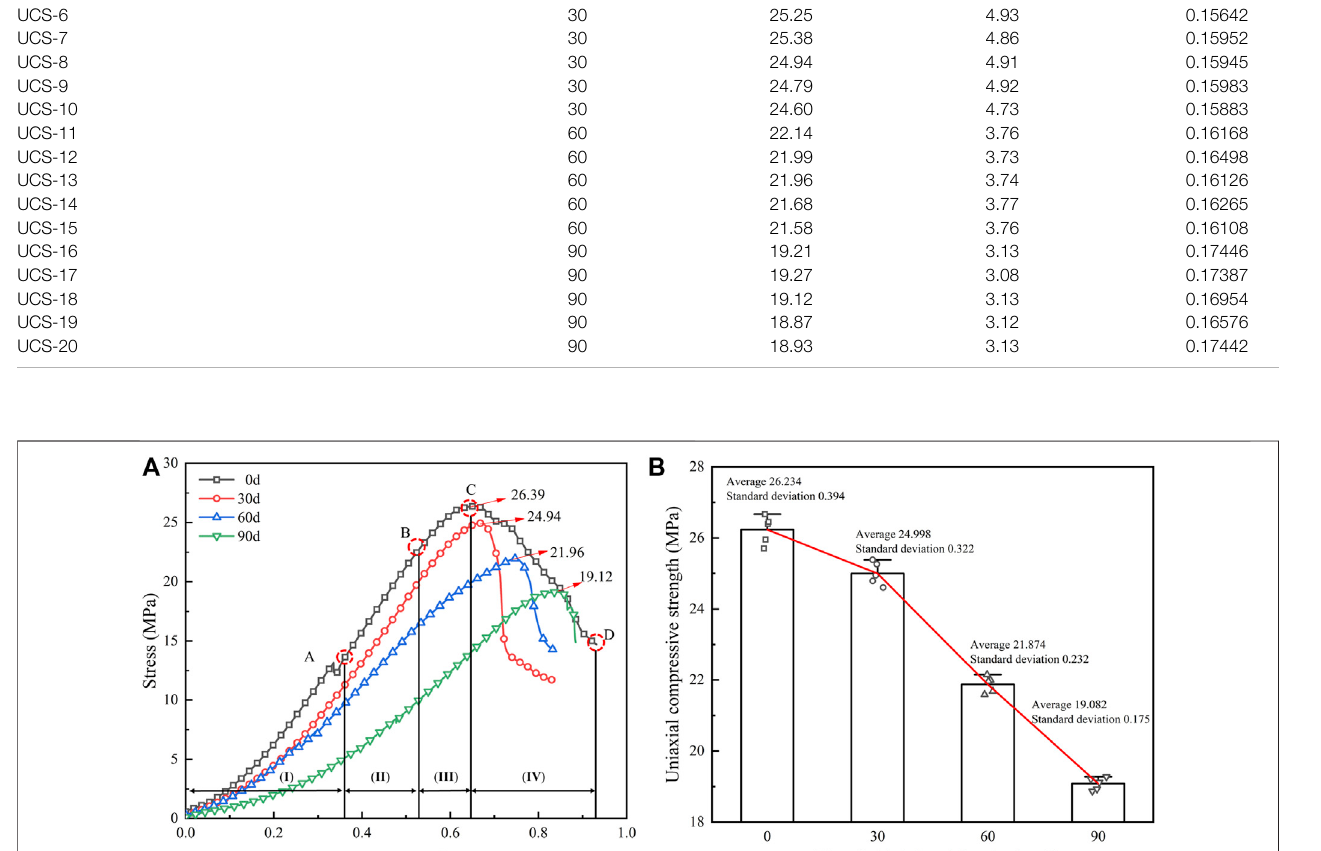
Frontiers in Materials |